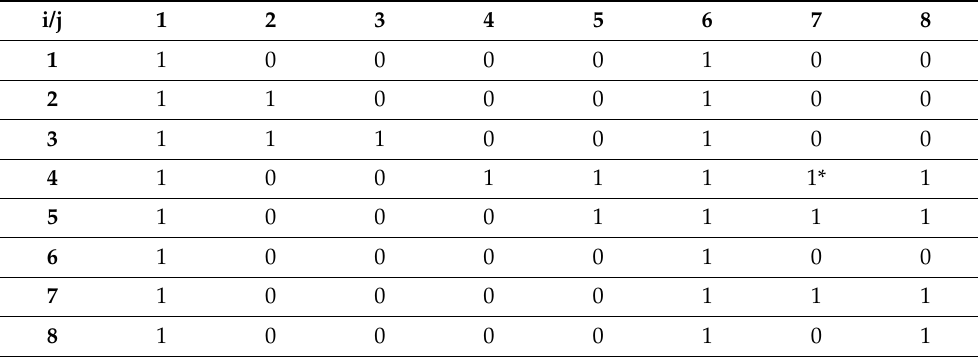
Table 2. Final Reachable Matrix